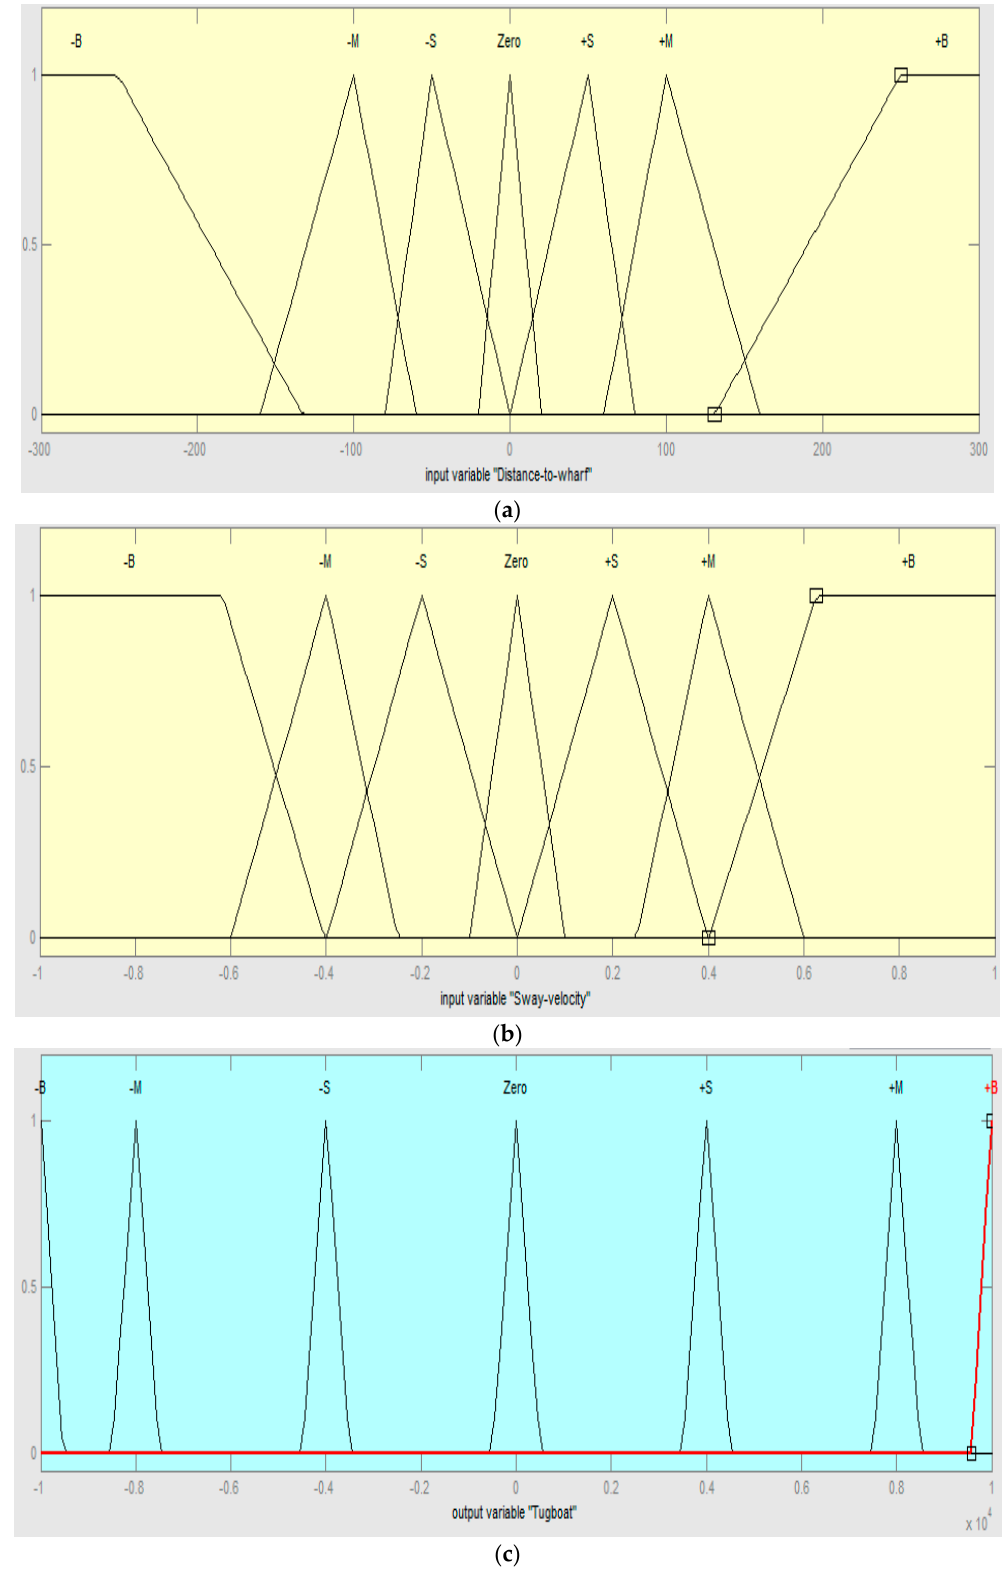
Figure 9. The membership functions of inputs of the third fuzzy controller: ( a ) Distance to wharf; ( b ) sway velocity; ( c ) tugboat force and bow thruster force.